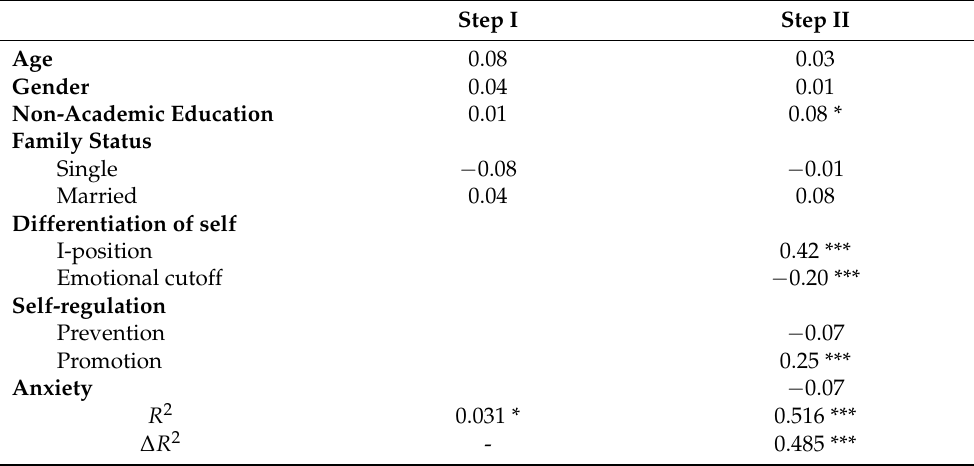
Table 3. Regression Standardized Coefficient (Betas) and R-Squares of Multiple Regression Analyses for Predicting Well-Being (N =